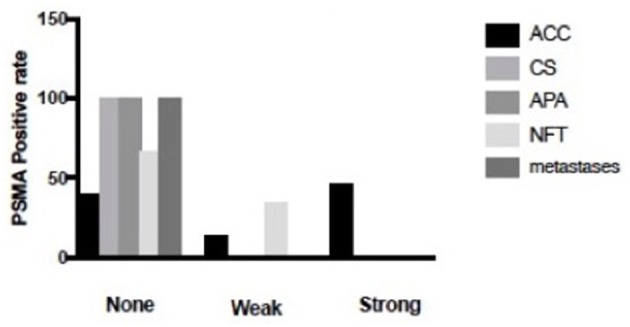
Percentage of composite PSMA scoring intensity of 150 cases. Of the 50 ACC cases, 40% of them were negative for staining, 14% of them were weakly stained, 46% of them were strongly stained. In contrast, 34% of the NFT was weakly stained, 66% of NFT was stained negative. What is more, 100% of CS, 100% of APA and 100% of metastases were negative for staining.